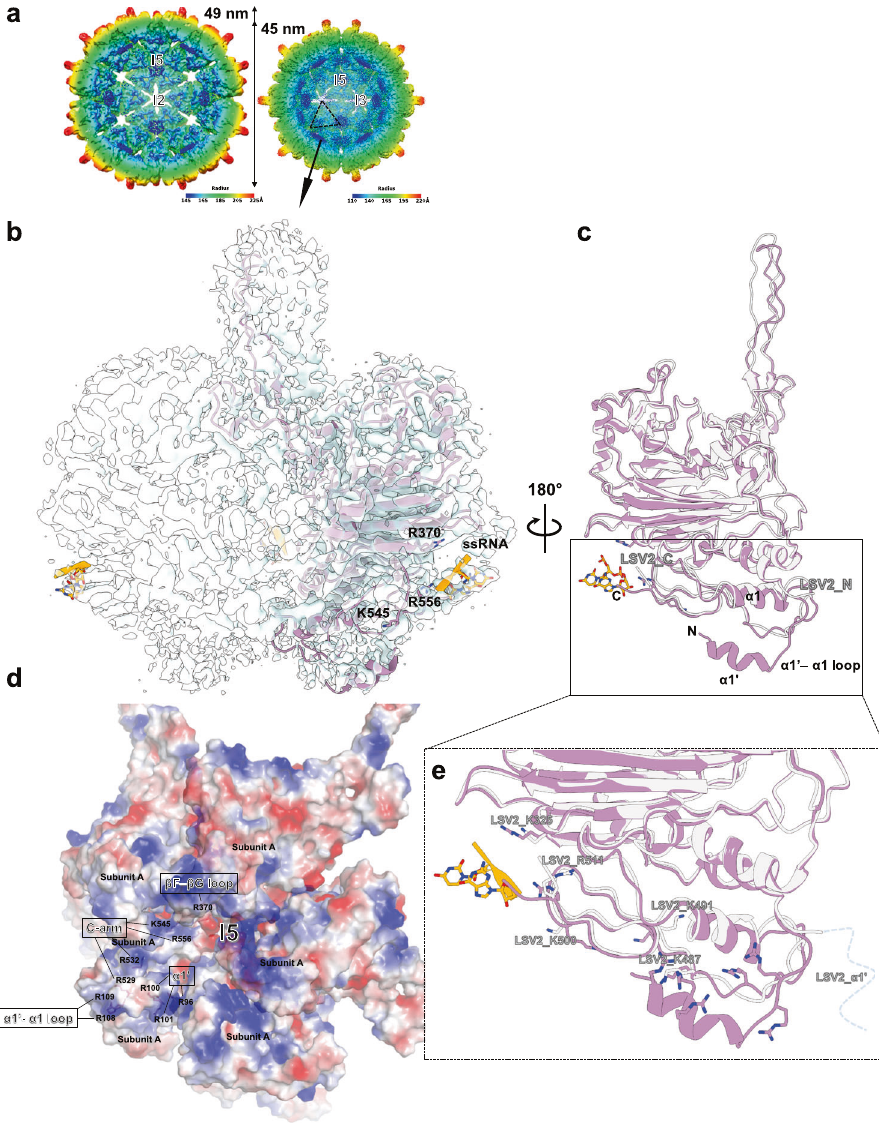
Fig. 3 | ssRNA binding of T =3 delta-N48 LSV1 VLP. a A cutaway view of the T =4 and T =3delta-N48LSV1VLPs.Ahalf-sectionalviewofthe T =4and T =3delta-N48 LSV1VLPsrevealstheobviousextraaveragedensity(blue)aroundtheinnersurface atI5,I3,andI2axes.The3Dmapiscoloredbyestimatesofradius. b Theportionof the cryo-EM map corresponding to one homo-trimeric capsomere in quasi- equivalent positions of the T =3 delta-N48 LSV1 VLP. The subunit A is shown as ribbondiagramscoloredinpurple.ssRNAsareshowninorange. c Superpositionof thesubunitsAfrom T =3LSV2anddelta-N48LSV1VLPs,andssRNAshowninsilver,